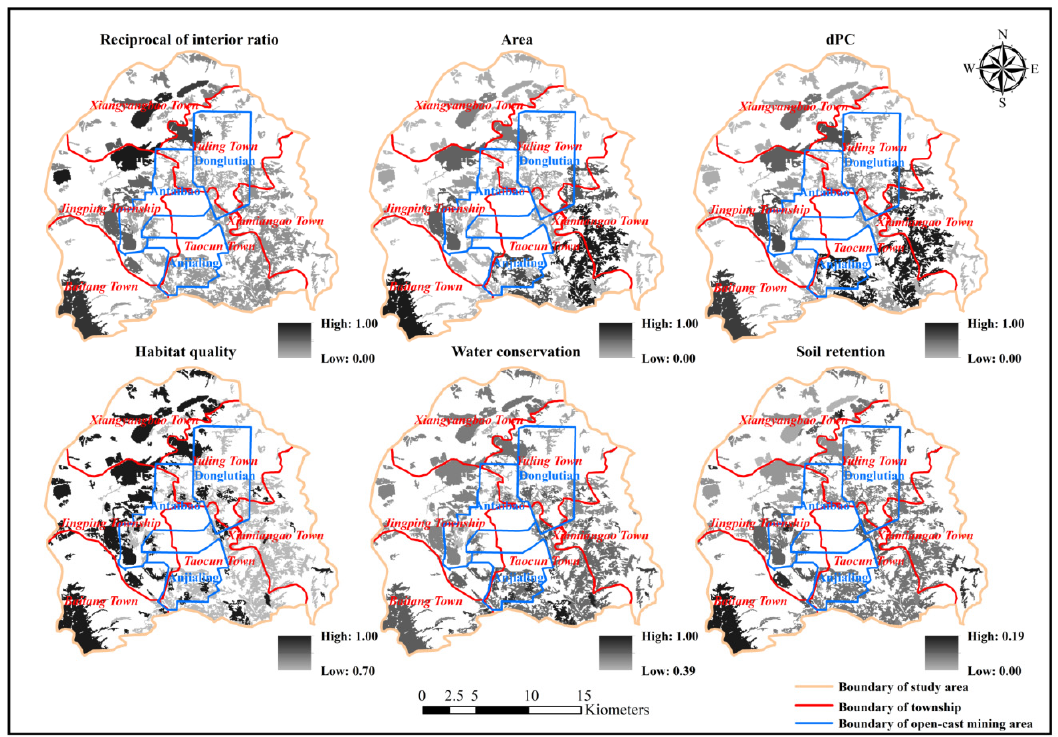
Figure 5. Values of potential ecological sources.